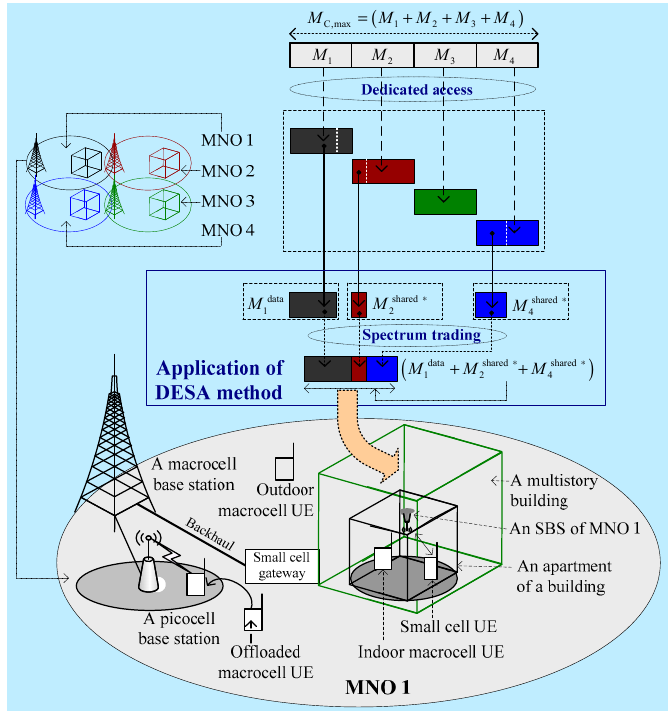
Figure 1. System architecture for four MNOs of a country applying the proposed DESA method. M C,max denotes the total amount of 28 GHz licensed mmWave spectrum countrywide. M 1 , M 2 , M 3 , and M 4 denote, respectively, the mmWave spectrum of MNO 1, MNO 2, MNO 3, and MNO 4. M data 1 denotes data traffic spectrum of MNO 1, whereas M shared from MNO 2 and MNO 4, respectively, such that they constitute the total mmWave spectrum of MNO 1 with applying DESA due to spectrum trading.